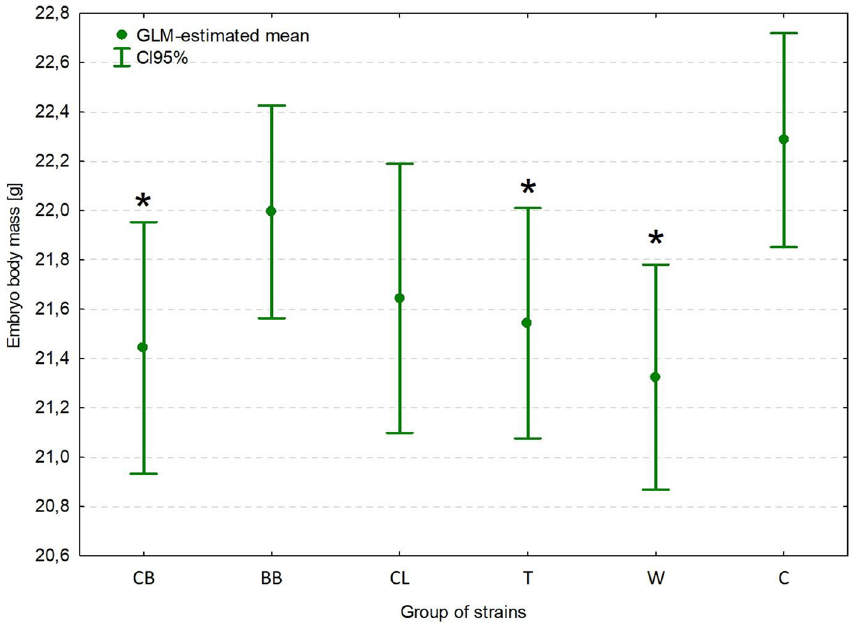
Figure 6. Body mass of SPF chicken embryos (7 dpi, 18 di) inoculated with Enterococcus cecorum strains. GLM-estimated mean of the body mass (95%